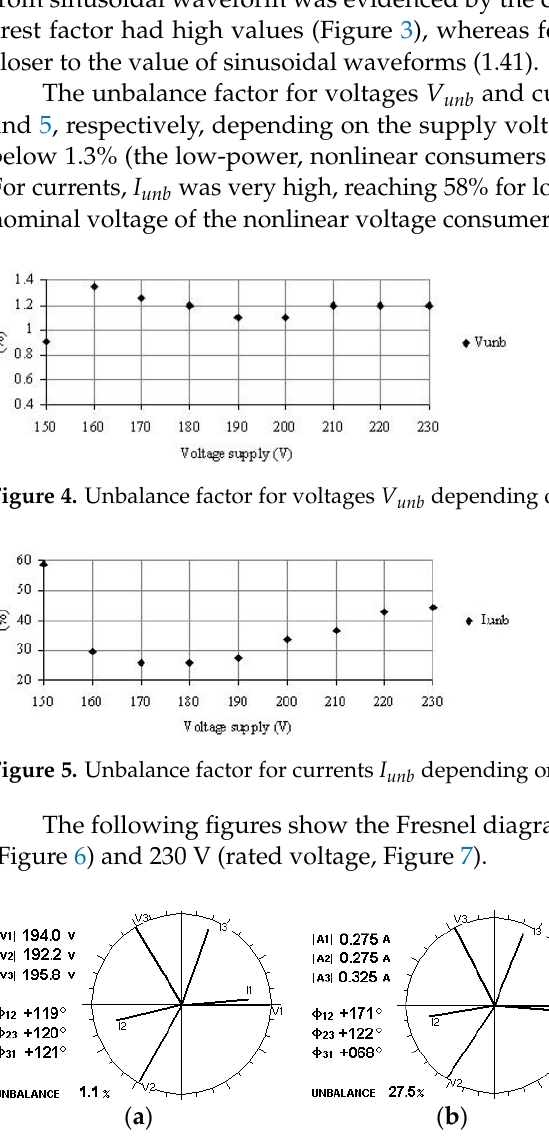
Figure 6. Fresnel diagrams for fundamental voltages and currents for 190 V phase voltage (set 1). ( a ) is voltages. ( b ) is currents.